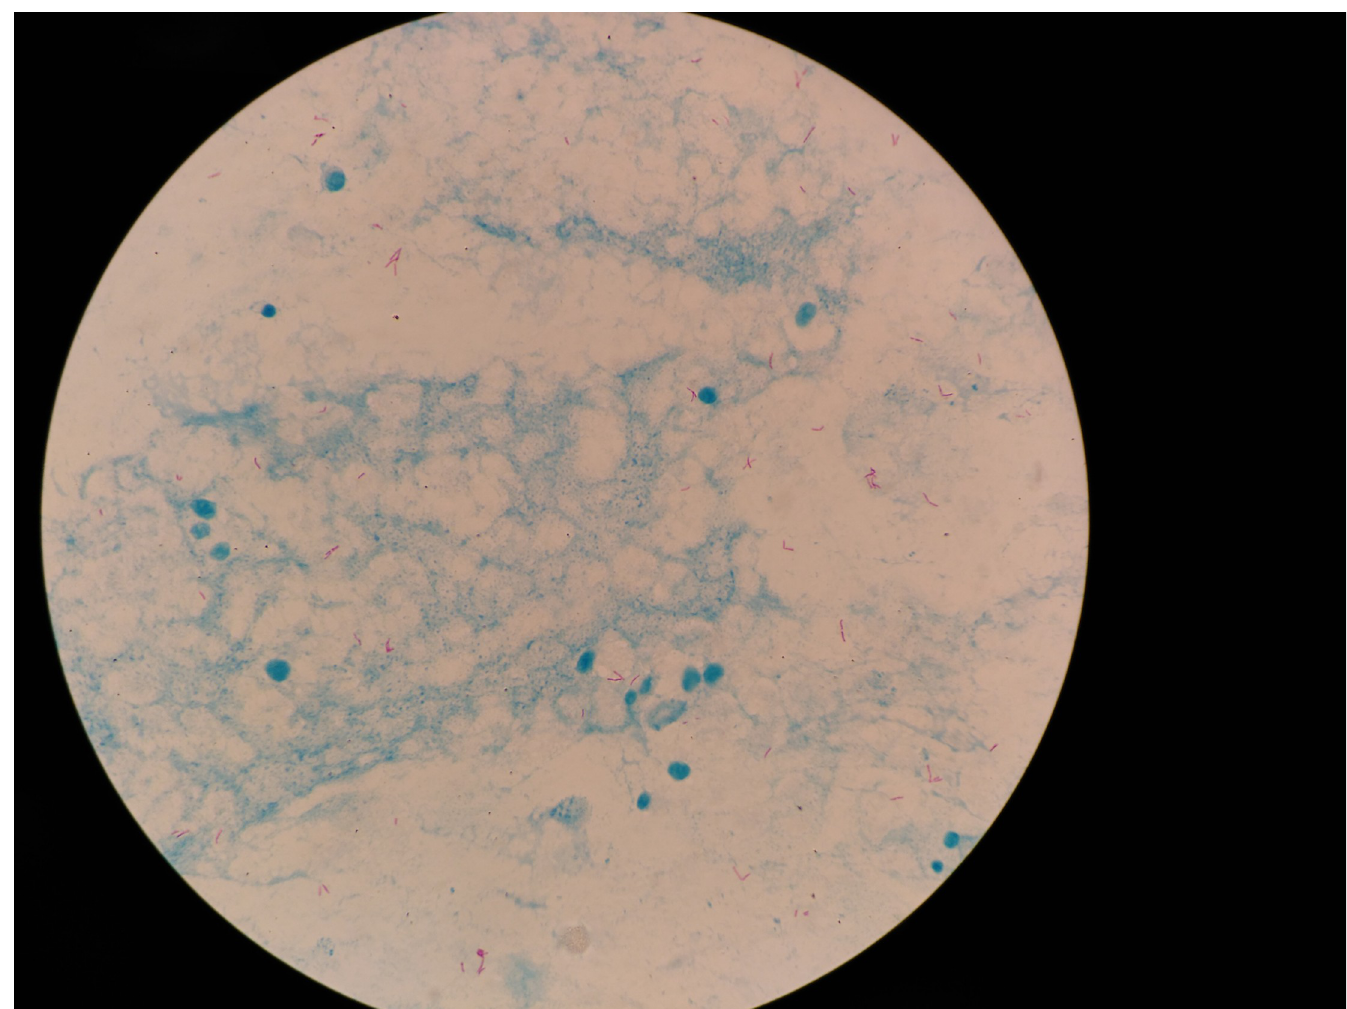
Fig 6. Original microscope image. 4160 � 3120